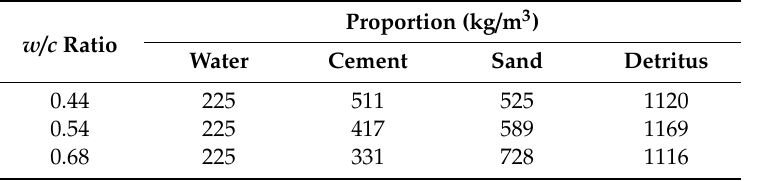
Table 1. Mixture proportion for concrete.